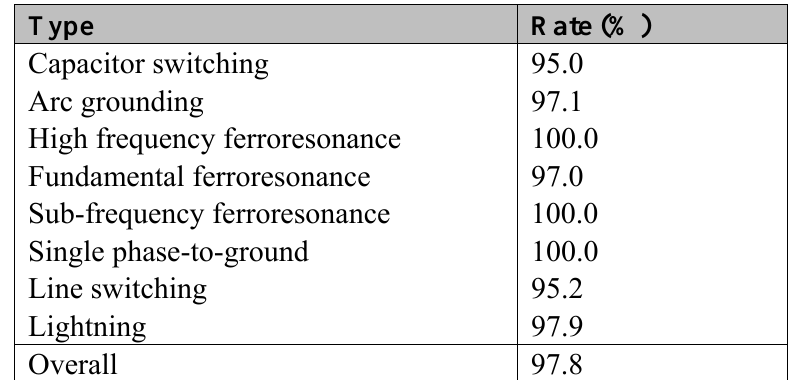
Table 6. Final identification